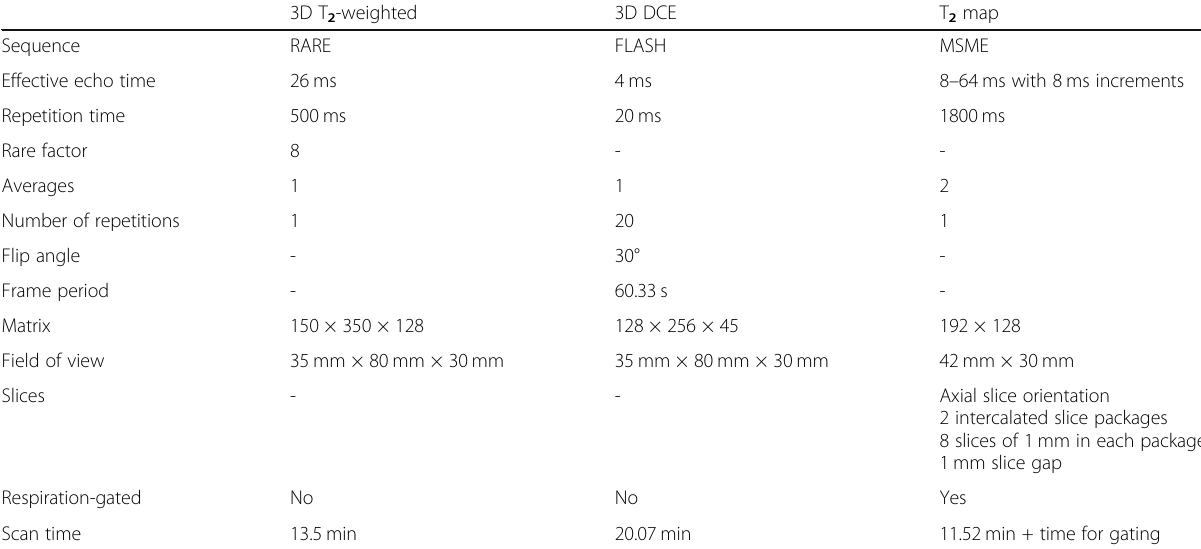
Table 1 Overview of MRI sequences and scan parameters 3D T 2